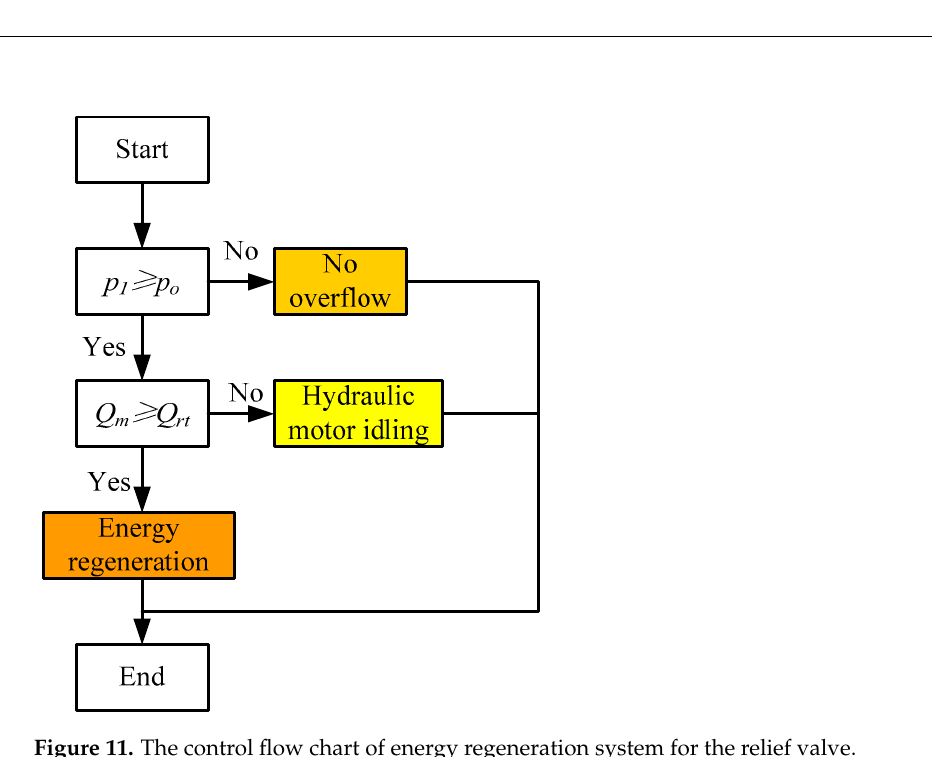
Figure 11. The control flow chart of energy regeneration system for the relief valve.